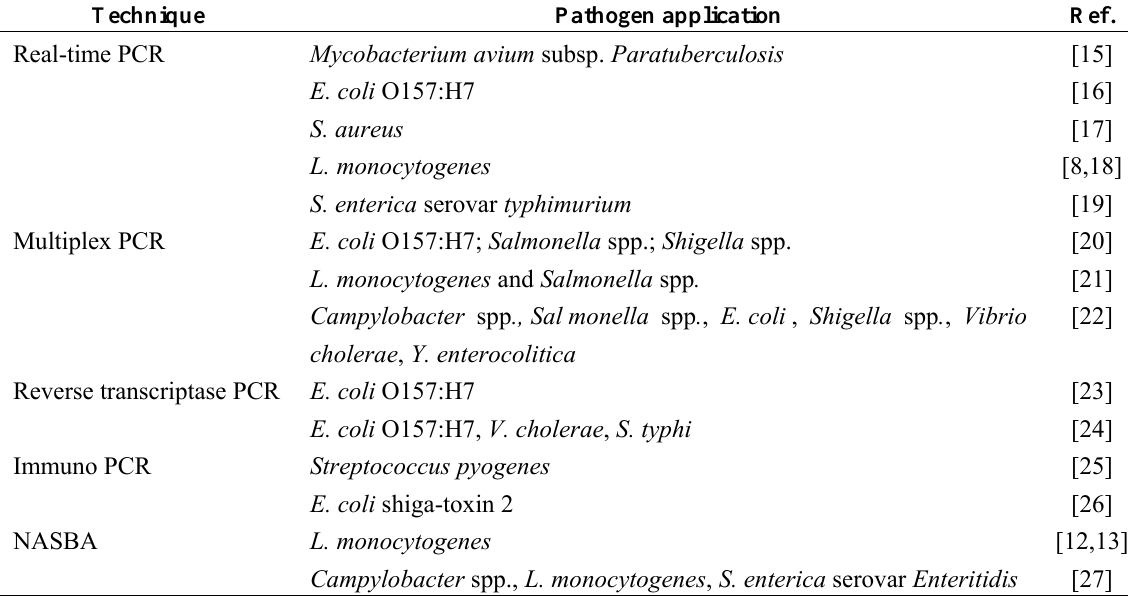
Table 3. A selection of nucleic acid-based protocols for pathogen